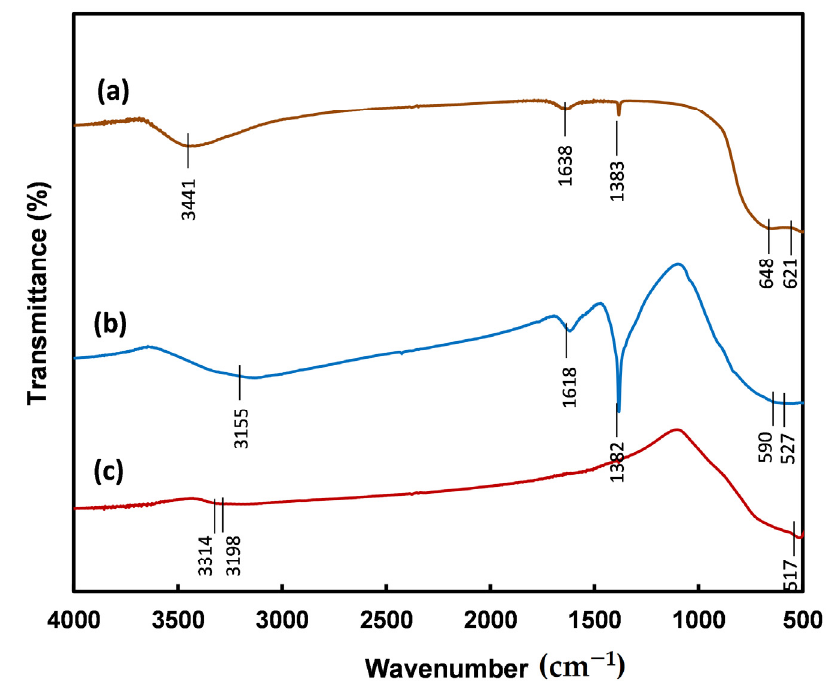
Figure 5. FT-IR spectra of ( a ) P25, ( b ) amorphous N/TiO 2 , and ( c ) anatase N/TiO 2 .